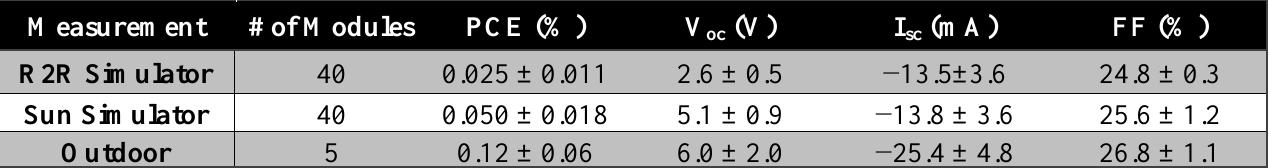
Table 1. Performance and standard deviations for the 15 mg/mL R2R modules produced and measured. The outdoor test includes both PC and PET encapsulated